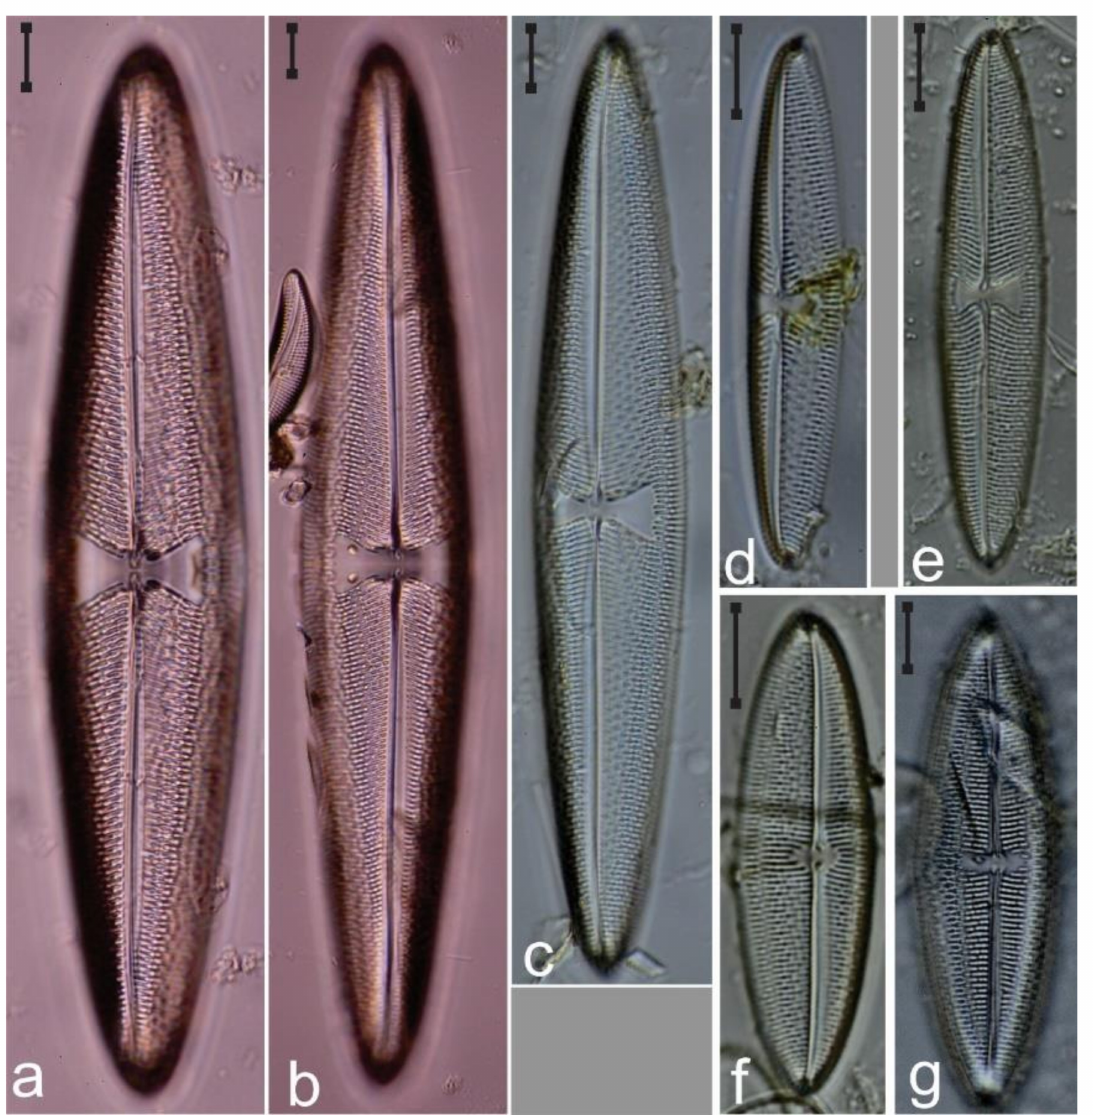
Figure 29. ( a – e ) Trachyneis aspera valves at di ff erent focal planes and showing range in size; ( f , g ) T. velata . Scale bar = 10 µ